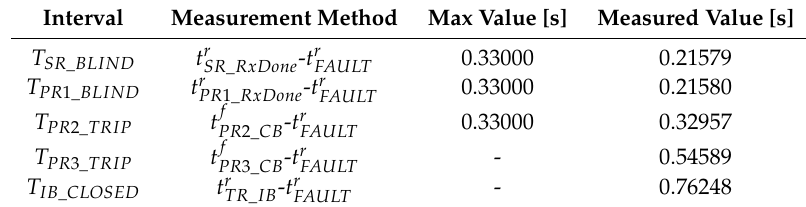
Table 17. Time intervals for fault clearing and interconnection reclosure for the fault 67N.S1. Case Study Interval Measured Value [s] Fault clearing time for fault 67N.S1 between SR and PR1 T SR _ TRIP 0.32839 Fault clearing time for fault 67N.S1 between PR2 and PR3 T PR 2_ TRIP Reclosure time for fault 67N.S1 between SR and PR1 Reclosure time for fault 67N.S1 between PR2 and